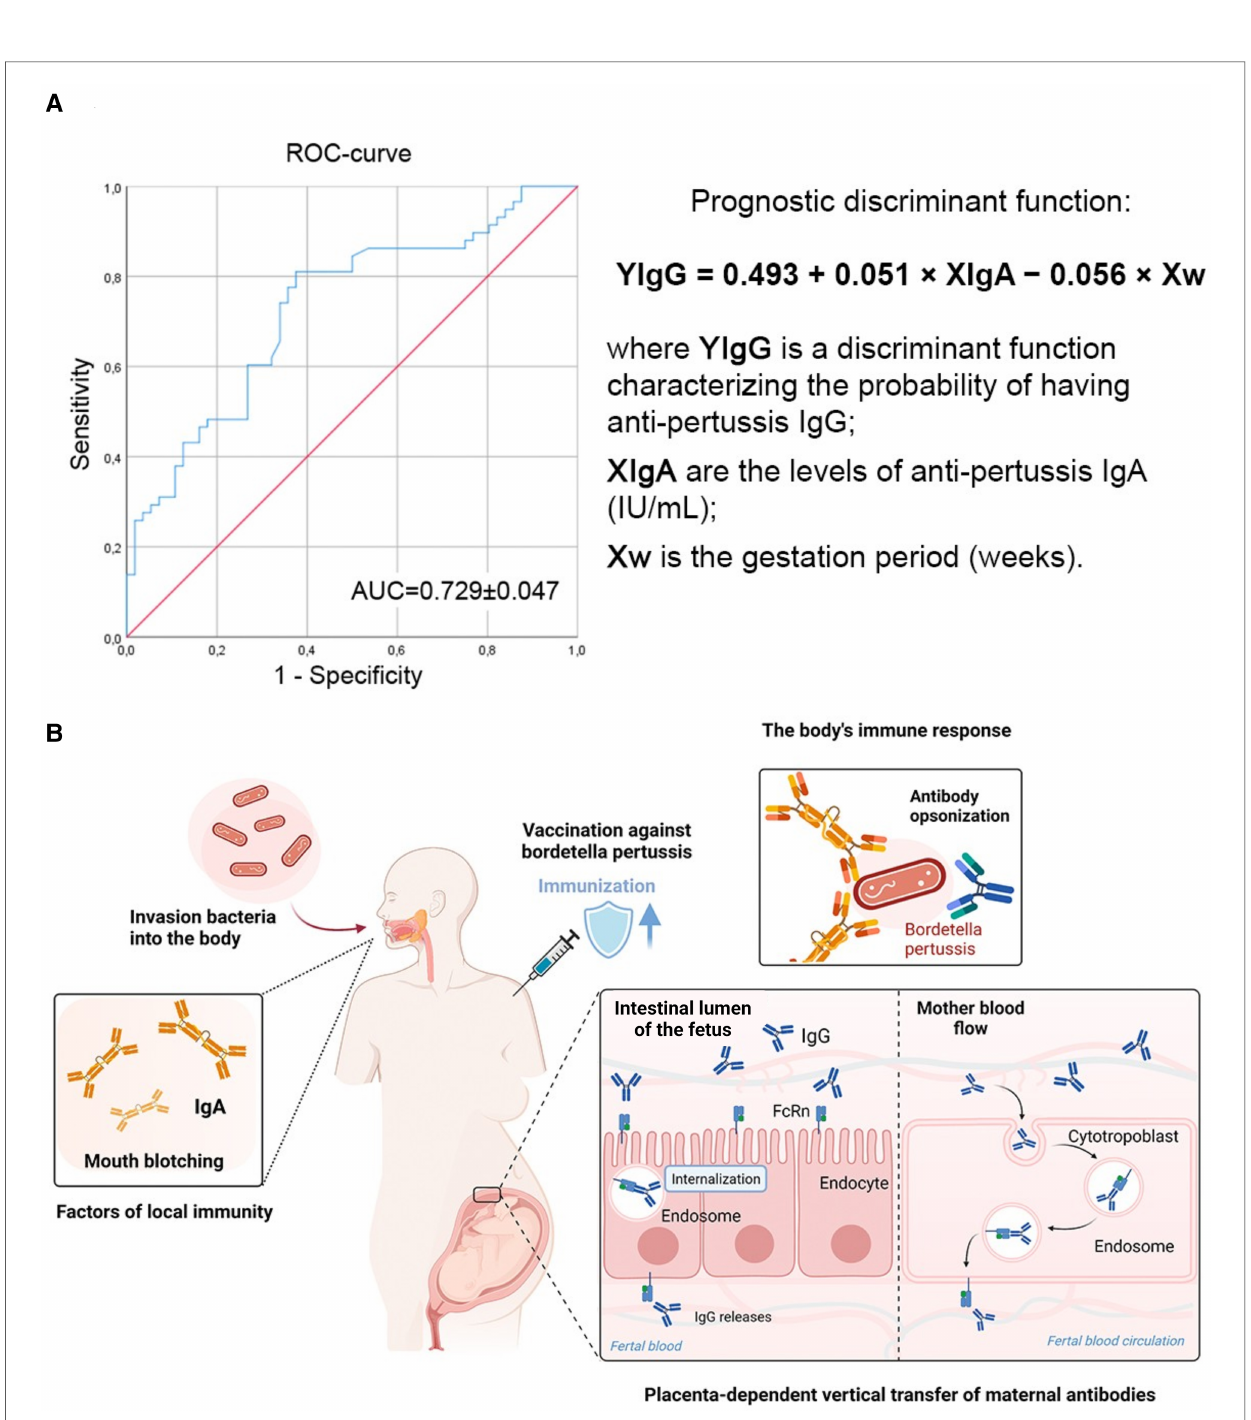
FIGURE 1 The presence of IgG to the pertussis pathogen depends on the levels of IgA and gestation period (weeks). ( A ) ROC-curve characterizing the dependence of the probability of having a protective level of anti-pertussis IgG on the values of the prognostic discriminant function. The area under the curve (AUC) was 0.729±0.047 with 95% CI: 0.63 – 0.822 ( p <0.001). ( B ) Circulation of speci fi c anti-pertussis IgA and IgG in pregnant women. Infant immunity against Bordetella pertussis is advanced by the placenta-dependent vertical transfer of maternal antibodies. Anti-pertussis IgA are produced together with anti- pertussis IgG after encounter with the Bordetella pertussis , but not during DTP